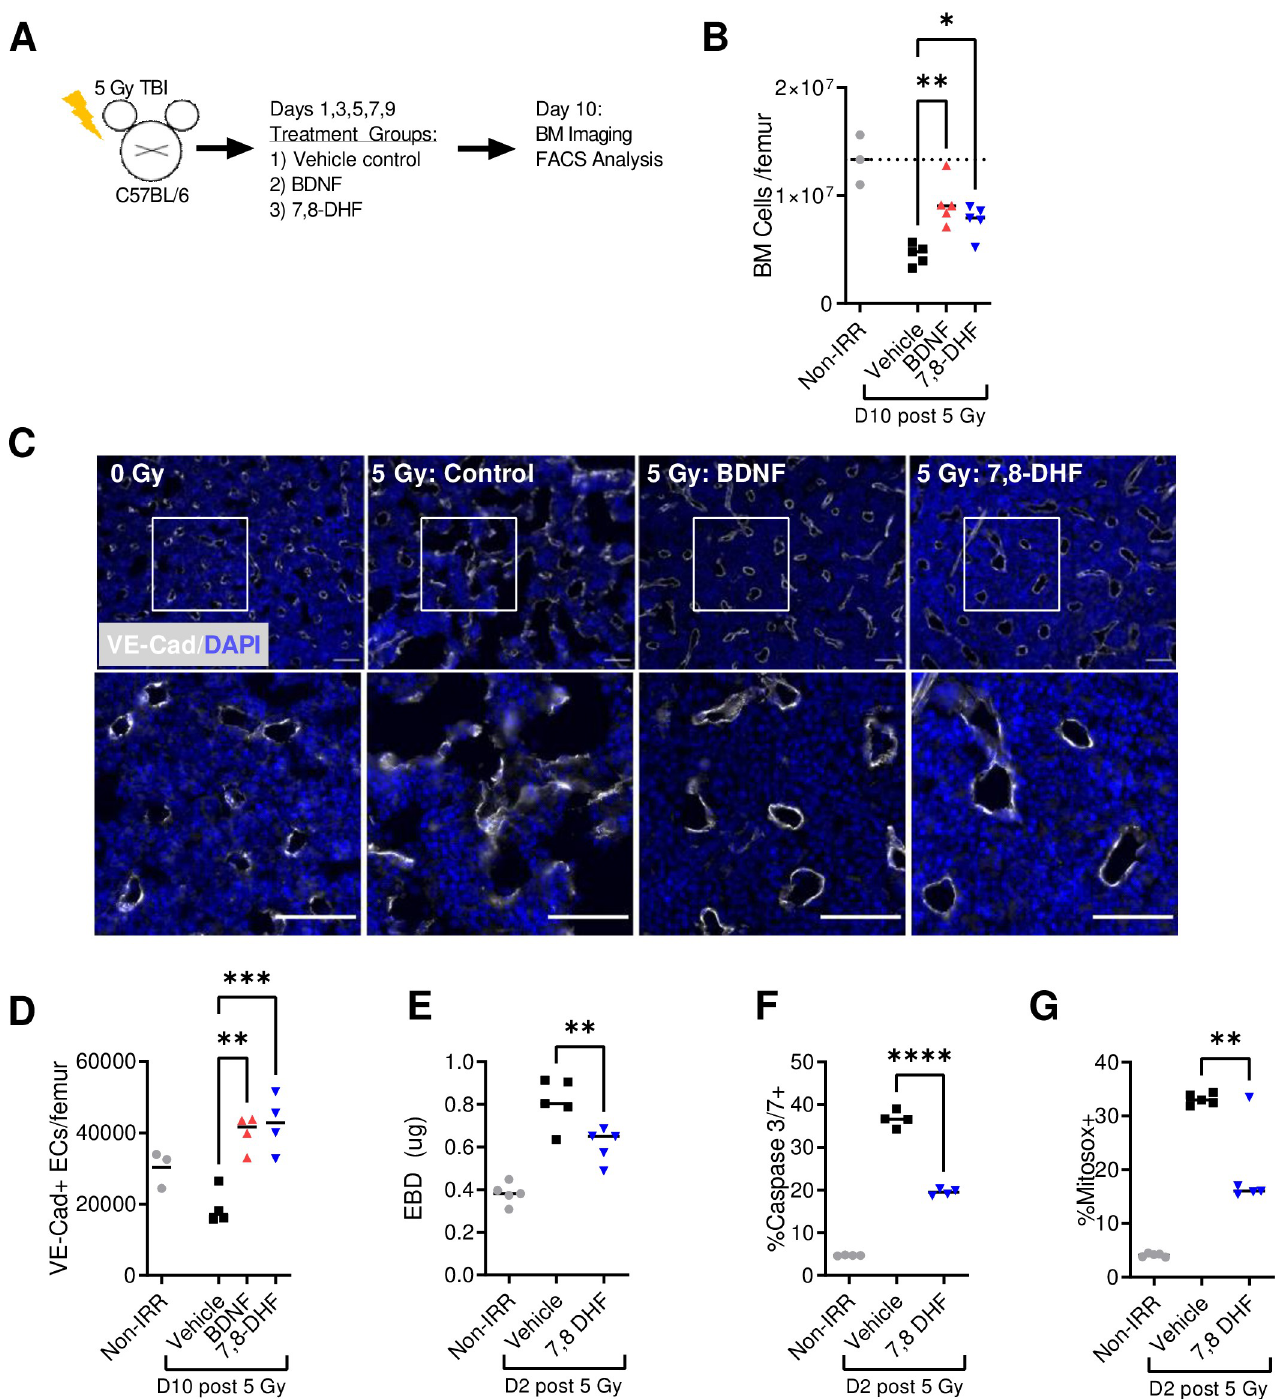
Fig 2. Pharmacologic activation of BDNF-TrkB signaling promotes recovery of the bone marrow niche following radiation injury. (A) Schematic representation of the experimental design: adult C57BL/6 mice were irradiated with 5 Gy and treated starting at 24 hours with vehicle, 0.5 mg/kg BDNF, or 1 mg/kg 7,8-DHF. (B) Total bone marrow cells per femur at day 10 (n = 5 mice per treatment). (C) Representative longitudinal femur sections labeled with VE- cadherin (white) and DAPI (blue) at day 10 following 5 Gy TBI. Scale bar = 100 μ m. (D) Total ECs per femur at day 10. (E) EBD permeability at day 2. (F) Percent ECs positive for active caspase 3/7 at day 2. (G) Percent ECs positive for Mitosox at day 2. (n = 4 mice per treatment). � P < .05, �� P < .01, ��� P < .001, ���� P <